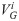
Relationships ‘maximal uptake rate vs initial nutrient concentration’ and ‘biomass yield vs initial nutrient concentration’ observed for C. glabrata growing on glucose.Relationships between the maximal uptake rate V and the initial nutrient concentration N0 (left panels) and between the yield Y and the initial nutrient concentration N0 (right panels) observed for C. glabrata growing on glucose. Dots with error bars (estimated values ± SE, where SE might be obscured by values) represent optimal estimates for parameters Vi with i = 1..3 (left panels) and Yi with i = 1..3 (right panels). These were obtained by fitting the model (2) to the experimental data on growth at the following initial glucose concentrations N0,i (i = 1..3): 0.025%, 1%, 2% (top panels, correspond to growth data shown in S1 Text, Appendix B, B5 Fig and S1 Text, Appendix A, A5 Table) and at the following initial glucose concentrations N0,i (i = 1..3): 0.2%, 1%, 1.6% (bottom panels, correspond to growth data shown in S1 Text, Appendix B, B6 Fig and S1 Text, Appendix A, A6 Table). Solid lines are the optimal non-linear least-squares fit of the function (8) (left panels) and of the function (3) (right panels) to the plotted data. Note that we refer to Vi and Yi in the context of Example 1, while the same parameters were labelled VGi and YGi in Example 2, with the subscript G distinguishing C. glabrata data used to parameterise the model of competition with C. albicans.